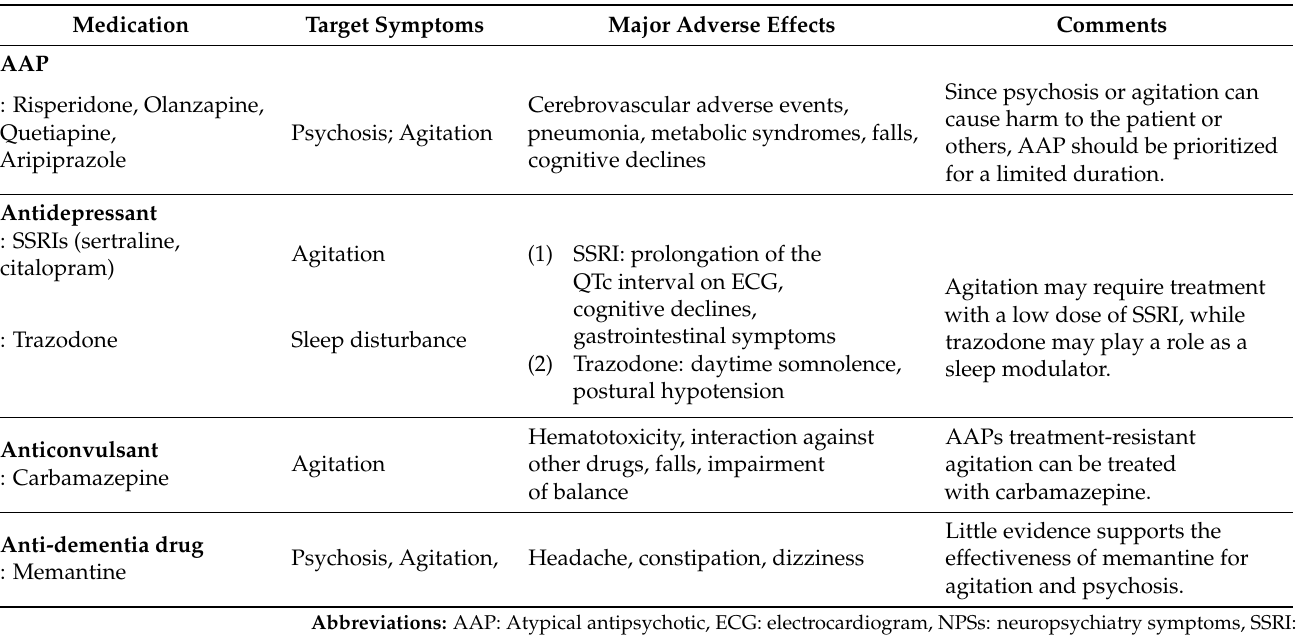
Table 1. Summary of recommended pharmacological treatments for NPSs in patients with Alzheimer’s disease [22].